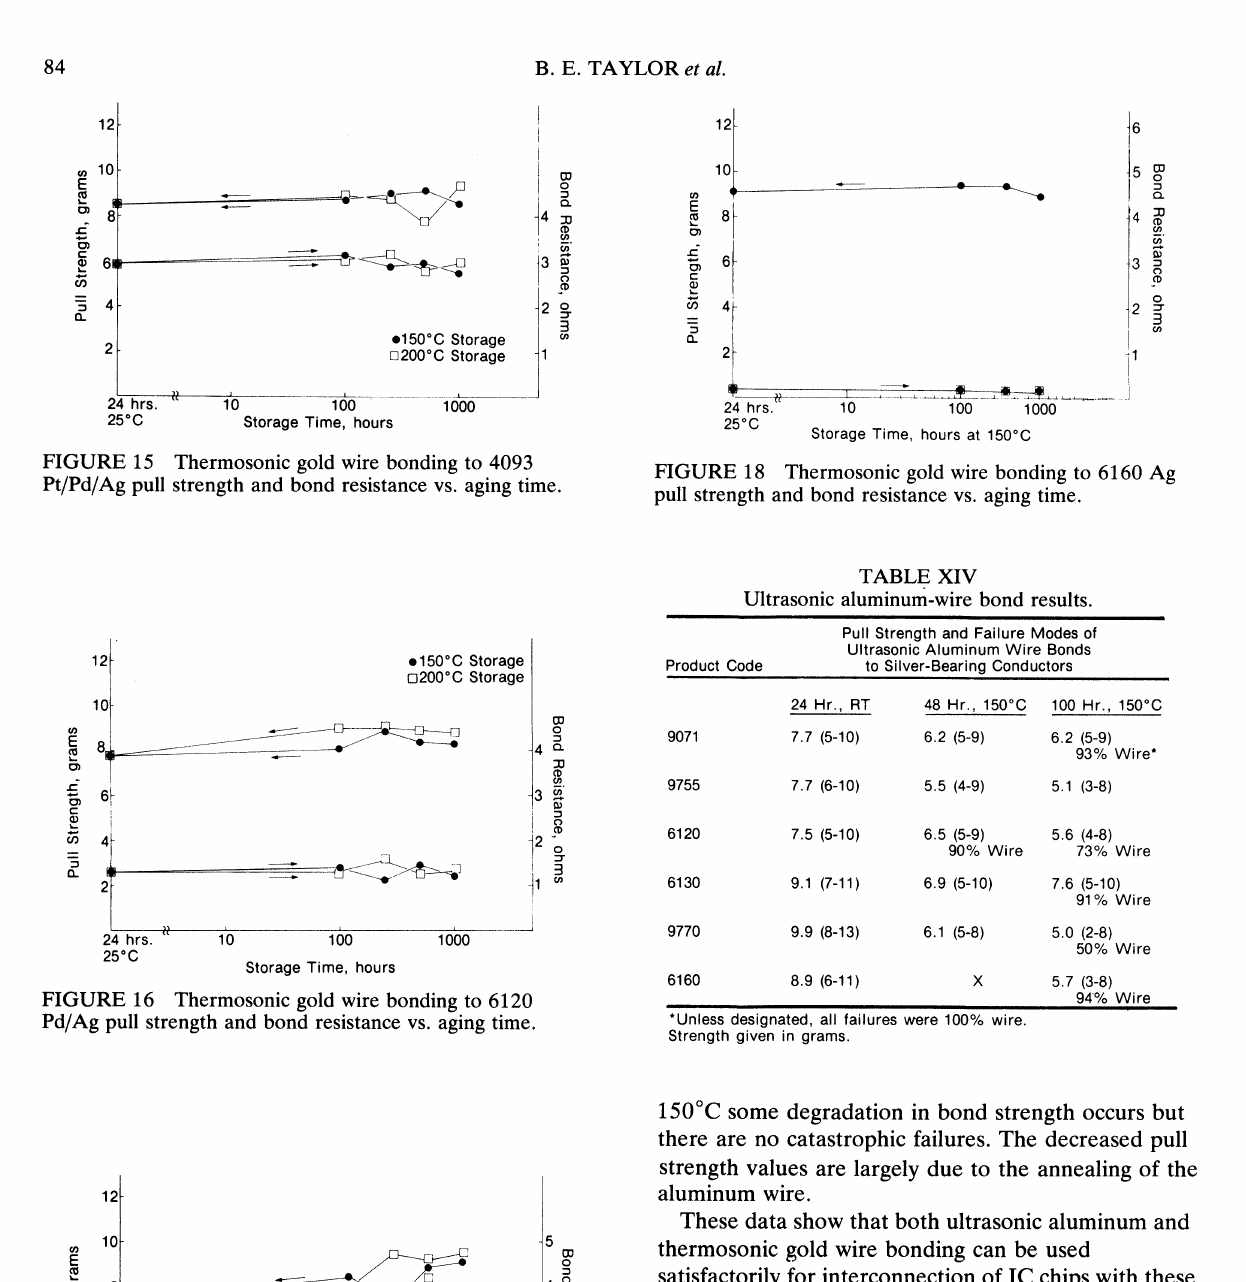
FIGURE 16 Thermosonic gold wire bonding to 6120 Pd/Ag pull strength and bond resistance vs. aging time.